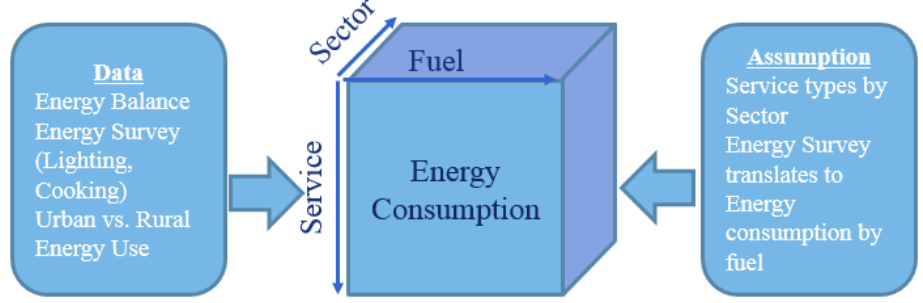
Figure 1. Construction of the Building Energy Consumption Data for the Base Year. Table 3. Disaggregated Energy Balance Table for the Building Sector (2010,